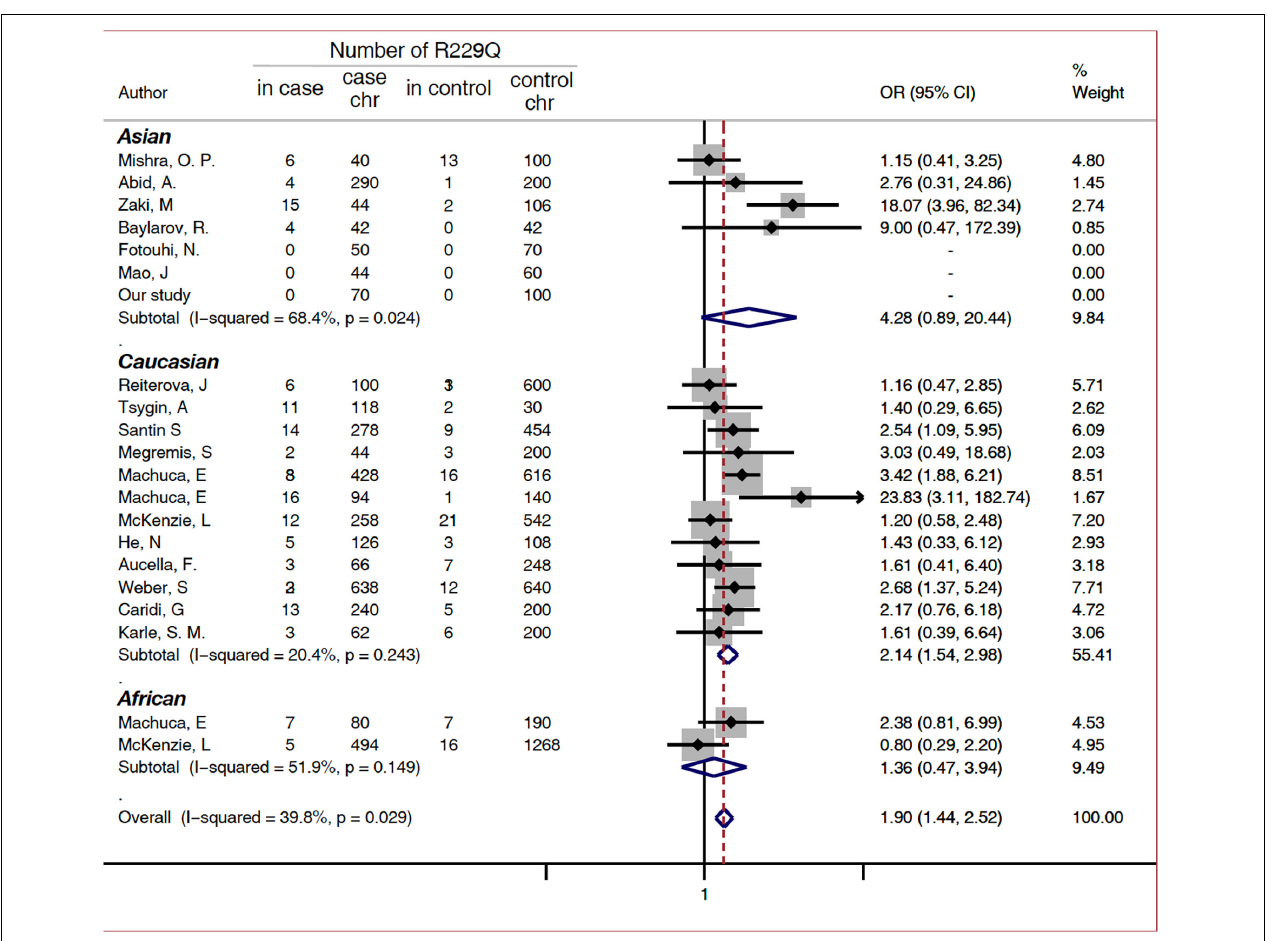
FIGURE 3 | Subgroup analysis of association between FSGS/SRNS and the p.R229Q variant based on ethnicity (allelic model). CI, confidence interval; OR, odds risk; chr, chromosome; SRNS, steroid-resistant nephrotic syndrome; and FSGS, focal segmental glomerular sclerosis.